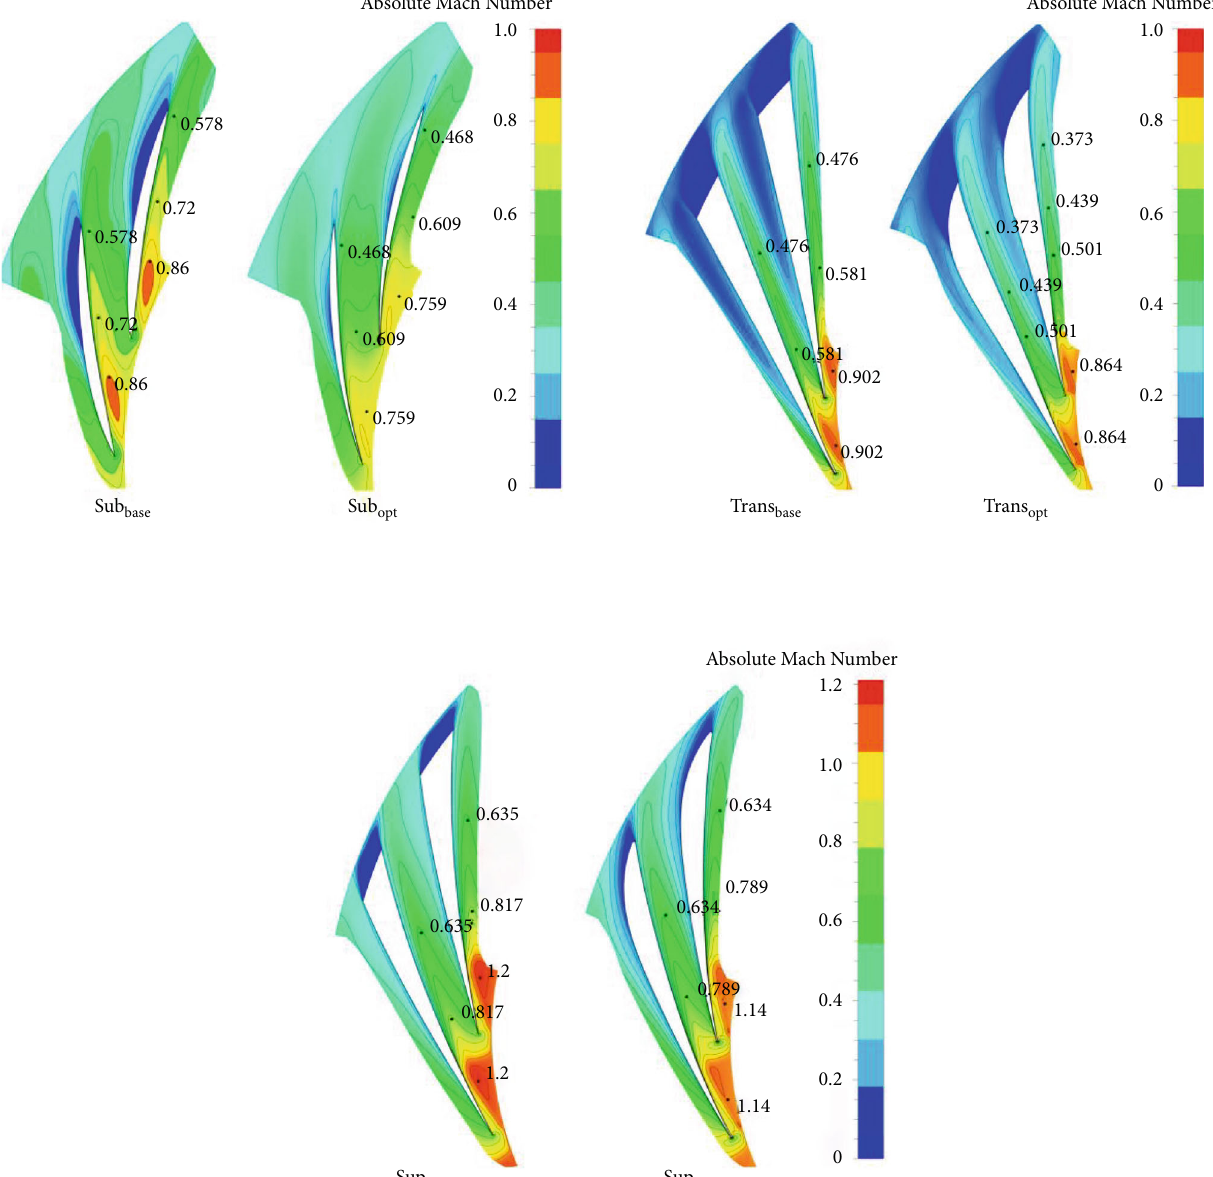
Figure 15: Mach number contours at the